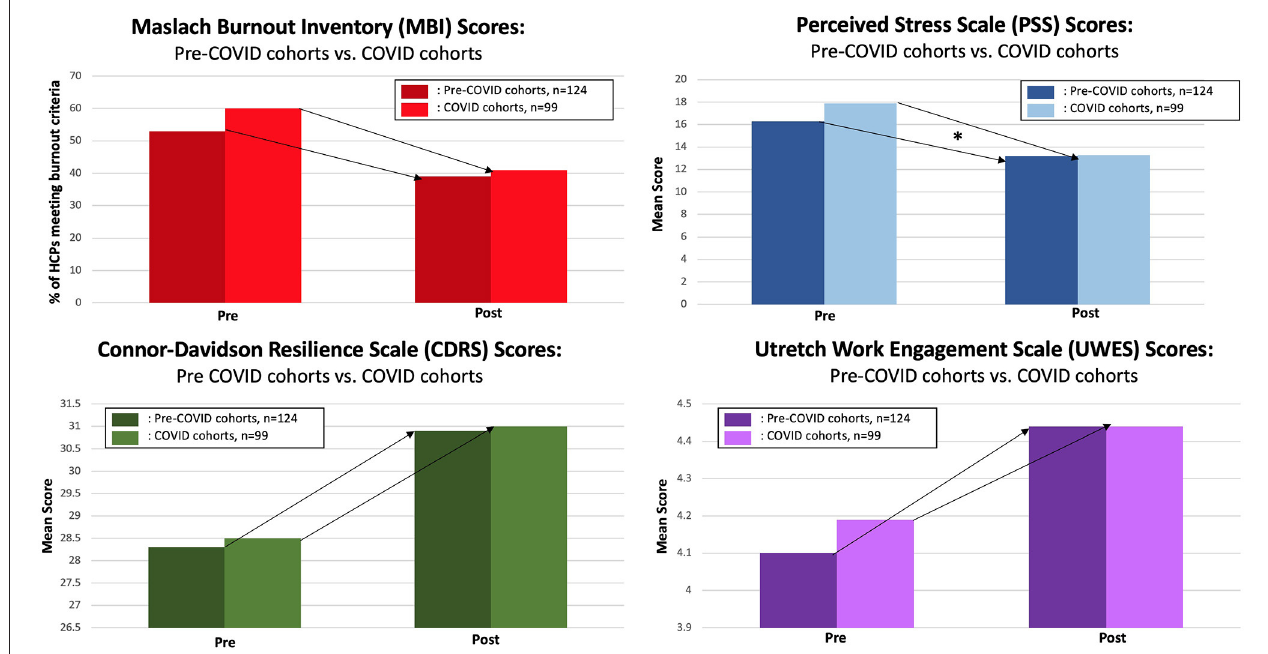
FIGURE 1 | Pre-COVID vs. COVID cohort comparisons on burnout, perceived stress, resilience, and work engagement (*denotes significant p -value, p <